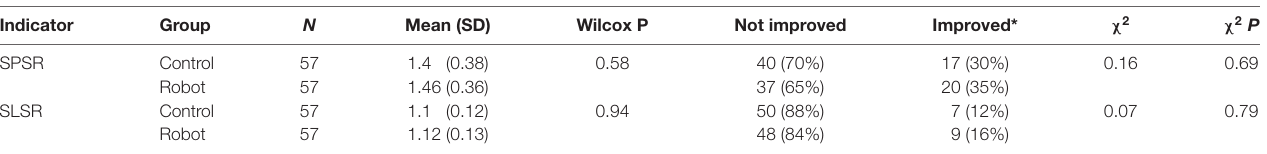
TABLE 2 | Gait symmetry indicators after 4 weeks of treatment on the subjects. Indicator Group N Mean (SD) Wilcox P Not improved